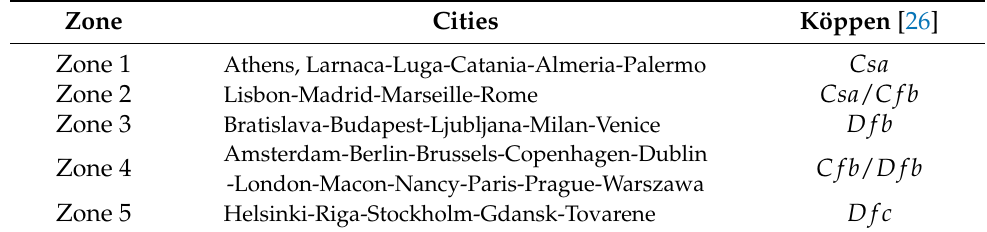
Table 2. Cities in NZEB climate